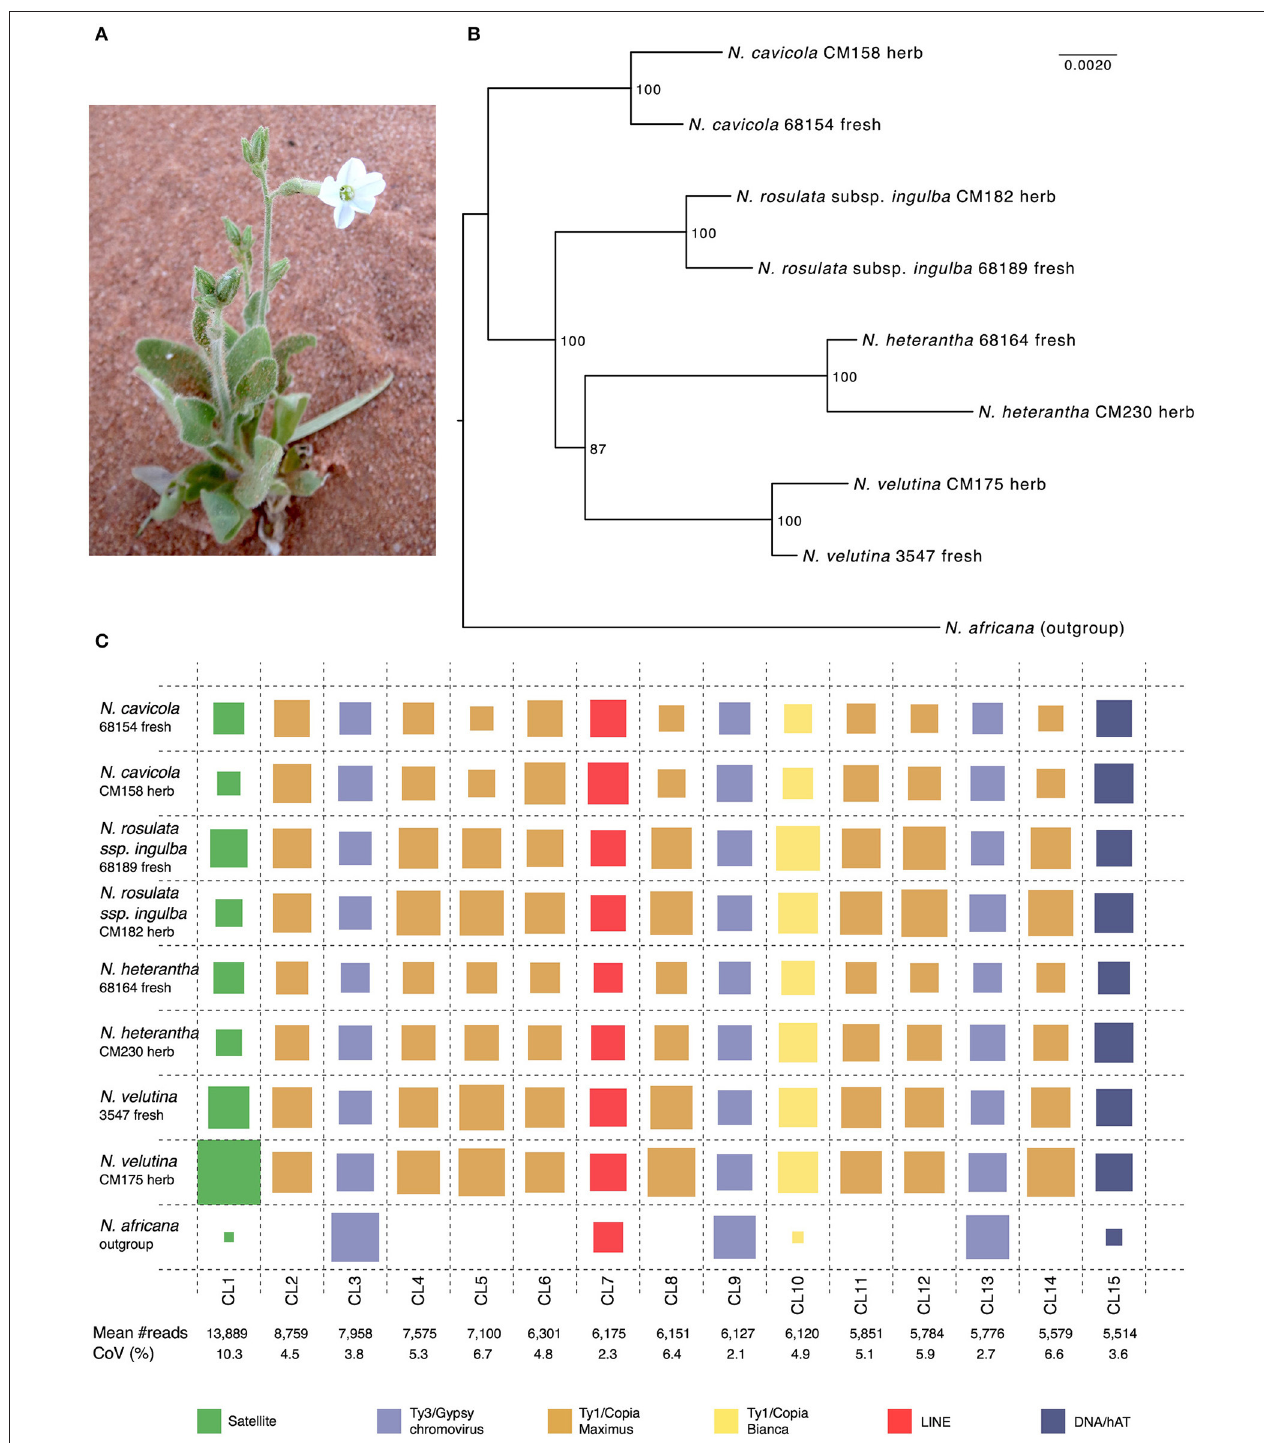
FIGURE 1 | (A) Nicotiana velutina from Witjira National Park, South Australia. (B) Maximum likelihood tree of the samples used based on ∼ 8.5 Kbp of rDNA sequence and 100 bootstrap replicates. (C) Comparison of the 15 largest (most abundant) repeat clusters from each taxon, CL1-15. Colors indicate the annotated type of repetitive elements: Class I LTR retroelements (Ty1/Copia or Ty3/Gypsy), Class I non-LTR retroelement (LINE), Class II DNA transposon (hAT) or satellite DNA. Size of rectangle is the proportion of reads in that cluster represented by that particular sample. Mean number of total reads per cluster and coefficient of variation (from three replicates) are shown